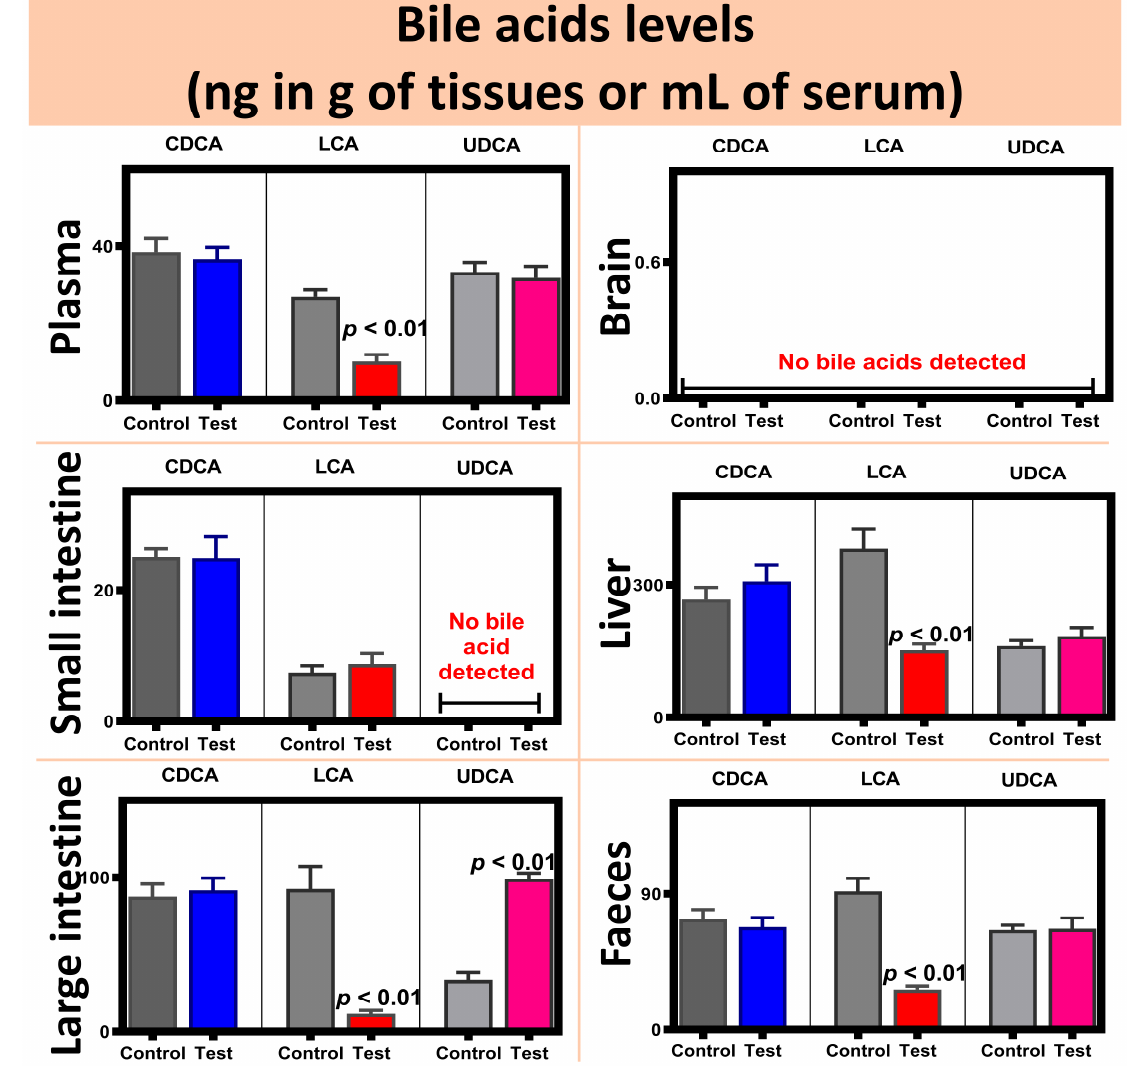
Figure 5. Endogenous bile acid profiling and quantification for CDCA (blue), LCA (red), UDCA (magenta) in plasma, brain, small intestine, liver, large intestine, and faeces of test and control (gray) mice groups. Data are mean ± SEM (n = 7).